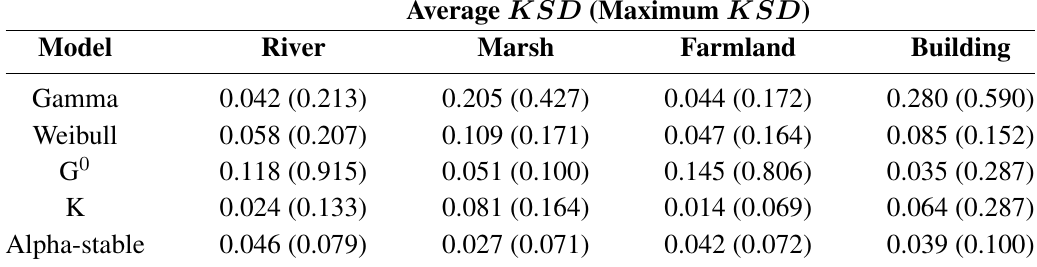
Table 2. Kolmogorov–Smirnov distance ( KSD ) of different statistical models.